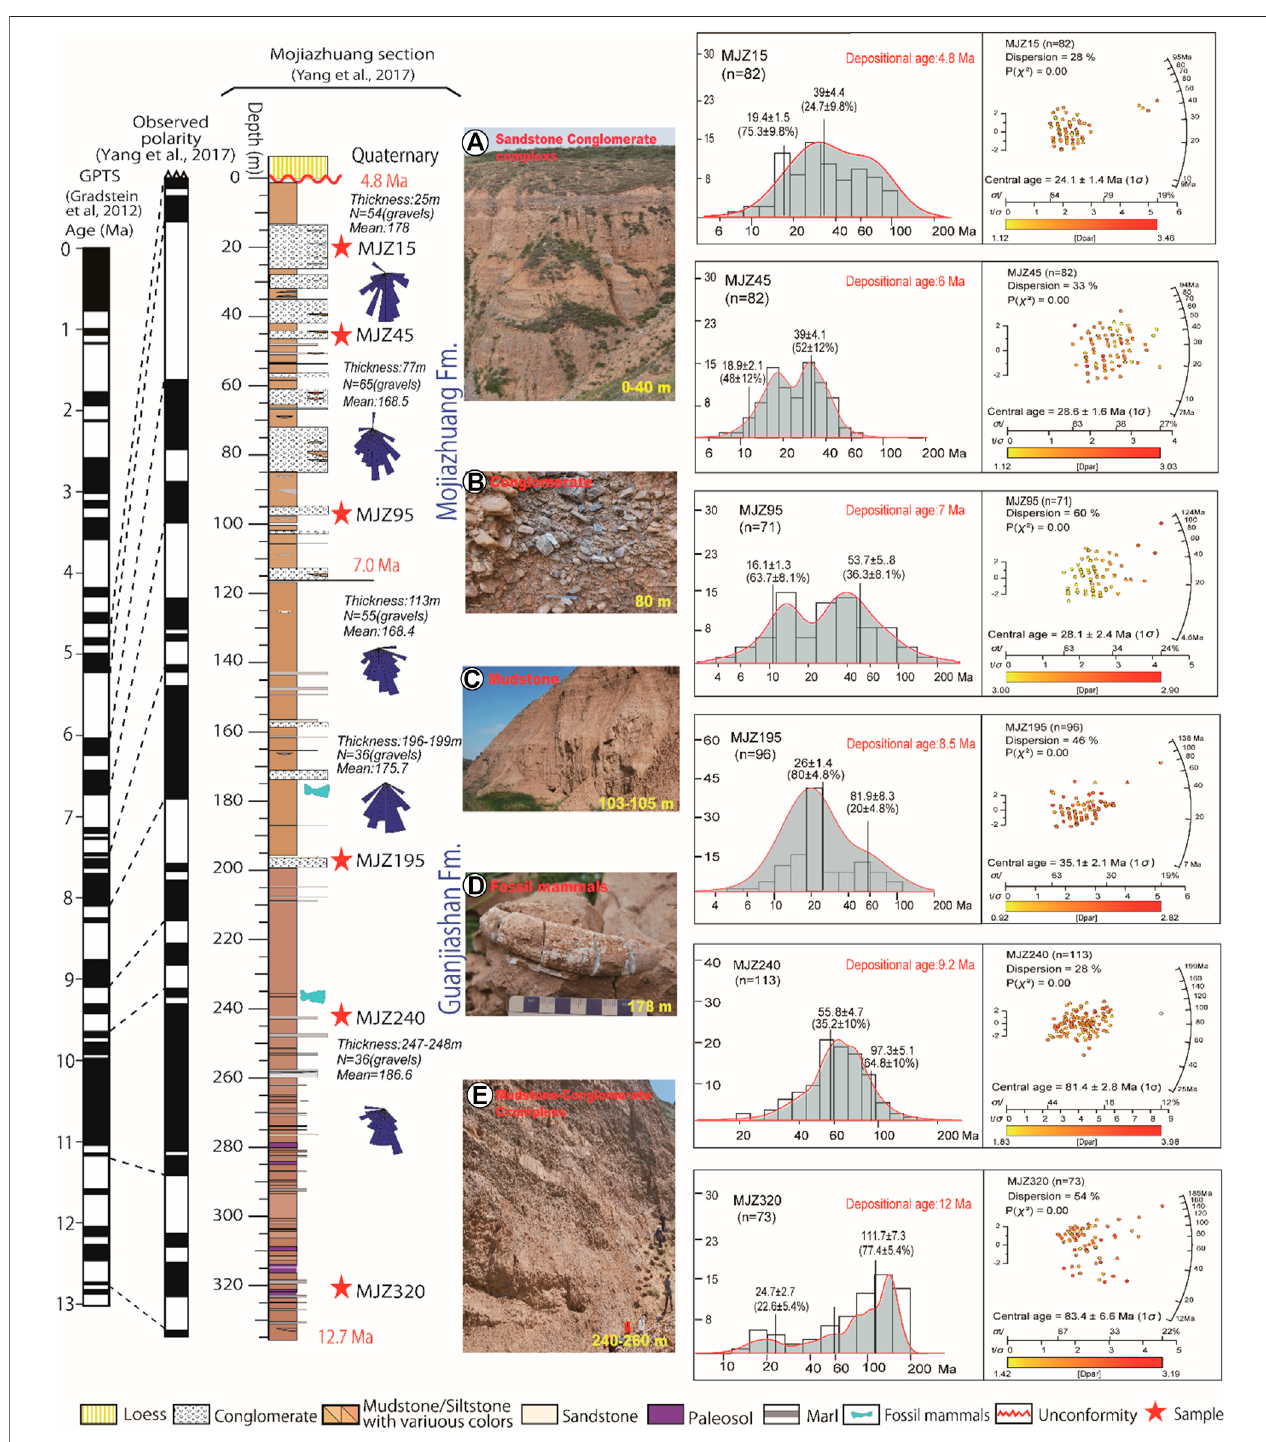
FIGURE3| Magnetostratigraphy,stratigraphiccolumn,paleocurrentdirections(allfromYangetal.,2017),samplingsites,andlow-temperaturethermochronology results for the Mojiazhuang (MJZ) section. The detrital AFT grain ages of the samples were statistically analyzed using RadialPlotter and DensityPlotter (Vermeesch, 2012). (A – F) Photographs of representative stratigraphy in the section.